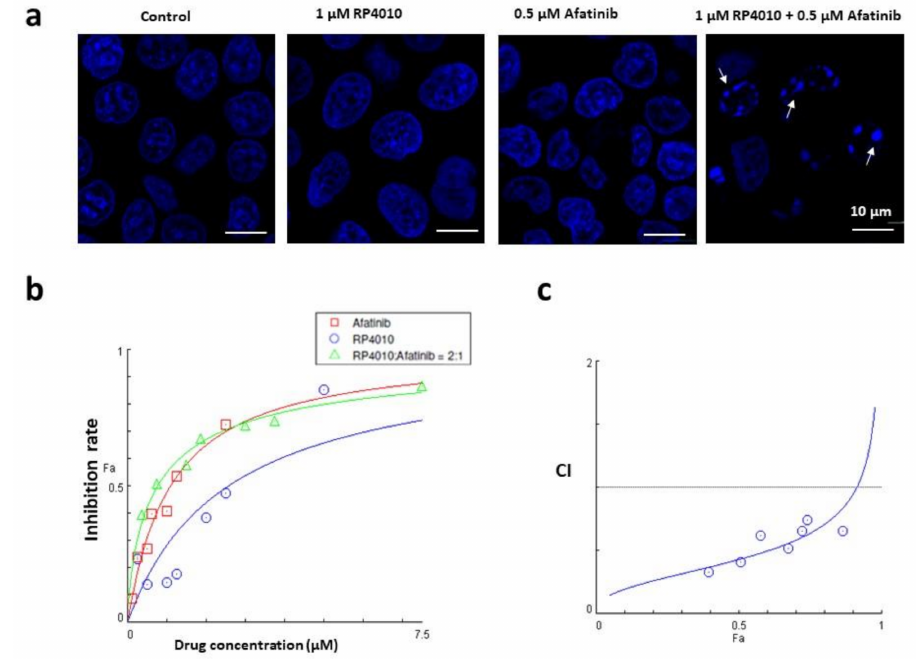
Figure 5. Synergetic effect of combined RP4010 and afatinib on cell viability in KYSE-150 cells. ( a ) Nuclei staining by Hoechst 33342 in KYSE-150 cells treated with vehicle control, 1 µ M RP4010, 0.5 µ M afatinib or 1 µ M RP4010 + 0.5 µ M afatinib. Apoptotic cells were indicated by nuclear DNA fragmentation and condensation (white arrow heads). Scale bar, 10 µ m. ( b ) Dose-dependent inhibition curves of KYSE-150 cells treated by RP4010 (blue circles), afatinib (red squares) or RP4010 plus afatinib (ratio 2:1, green triangles). Cell inhibition rates were measured by MTT assay. Details in the confined box were amplified as the upper curve. ( c ) Combination index (CI) plot for combined effect of RP4010 and afatinib. Each blue circle indicated a data point with combined RP4010 and afatinib. Simulation curve is shown in blue line. Average effect values (Fa) are shown on x